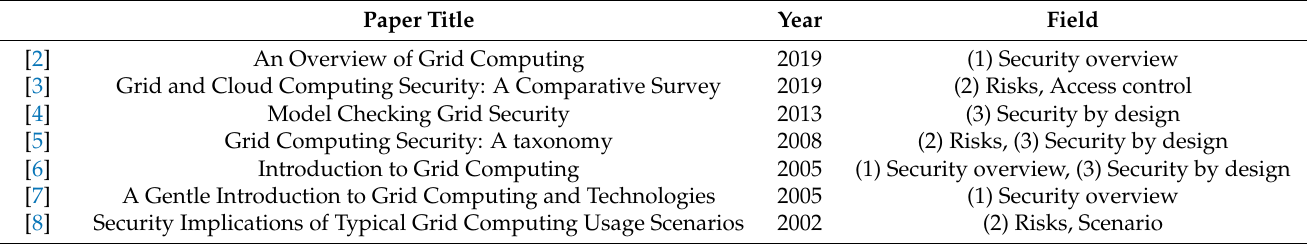
Table 1. List of the studies on the research trend for grid computing system security.